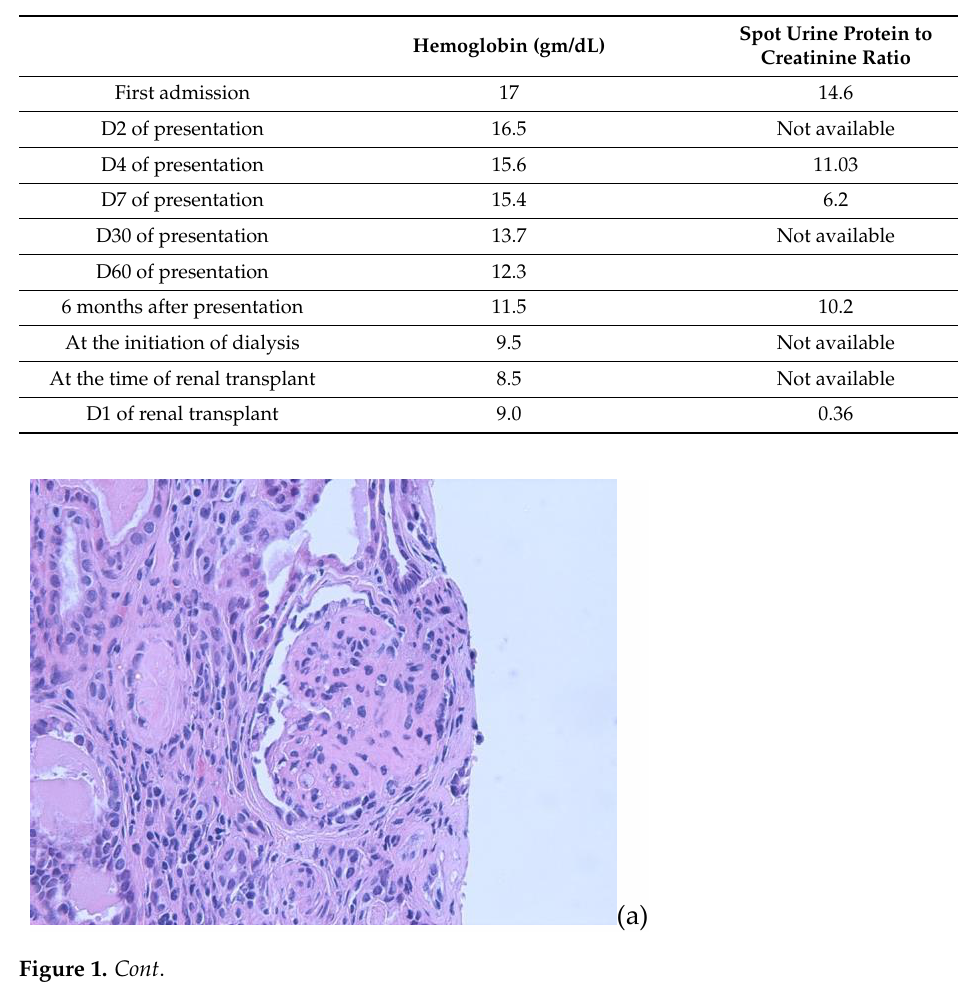
Table 1. Laboratory values of hemoglobin and spot urine protein and